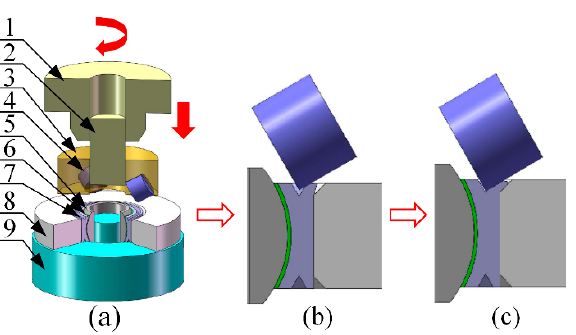
Figure 1. Schematic diagram of the process structure of the roller staking process: ( a ) Roller staking; ( b ) Staking process; ( c ) Staking completed. 1—machine tool fixture; 2—mandrel; 3—roller tool; 4—roller; 5—inner ring; 6—liner; 7—outer ring; 8—housing; 9—fixed fixture.